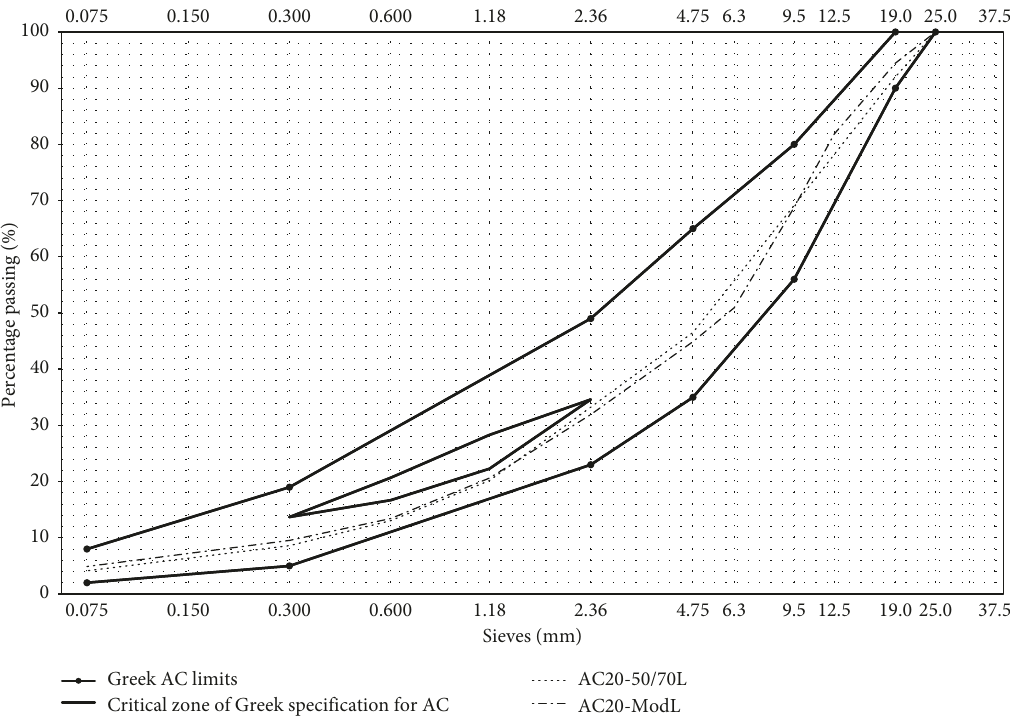
Figure 1: Gradation curves of AC20-50/70L and AC20-ModL.